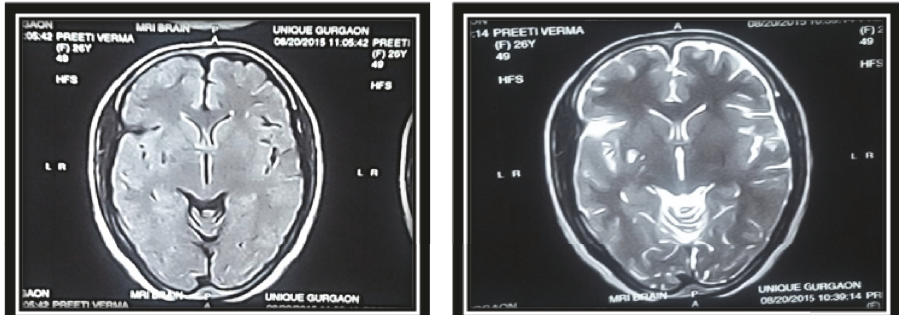
Figure 2: MRI brain scan reveals no focal pathology.